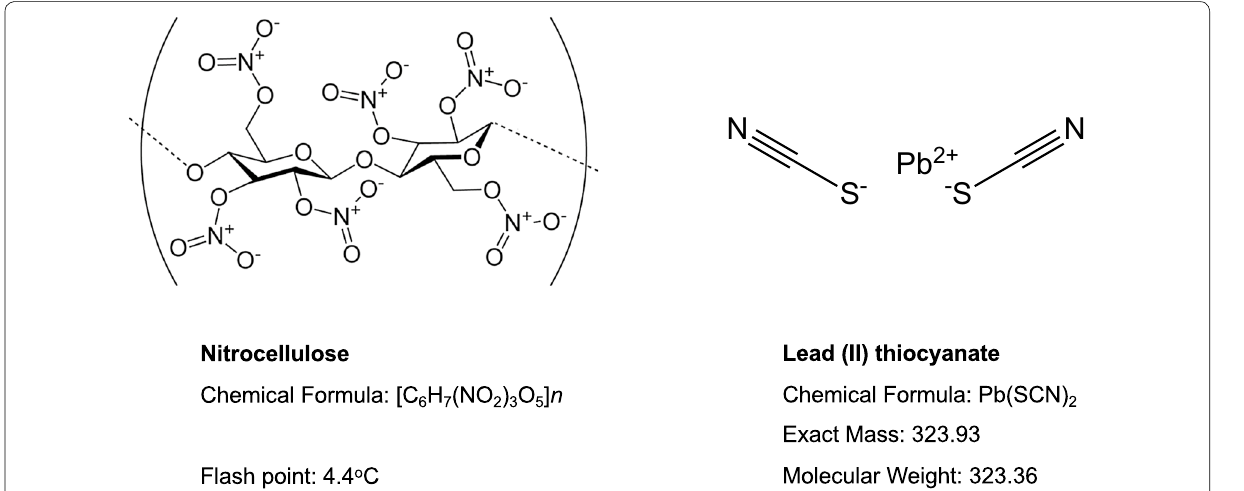
Fig. 2 Chemical structure of the nitrocellulose and lead(II) thiocyanate in the KTB and RK ignition charge